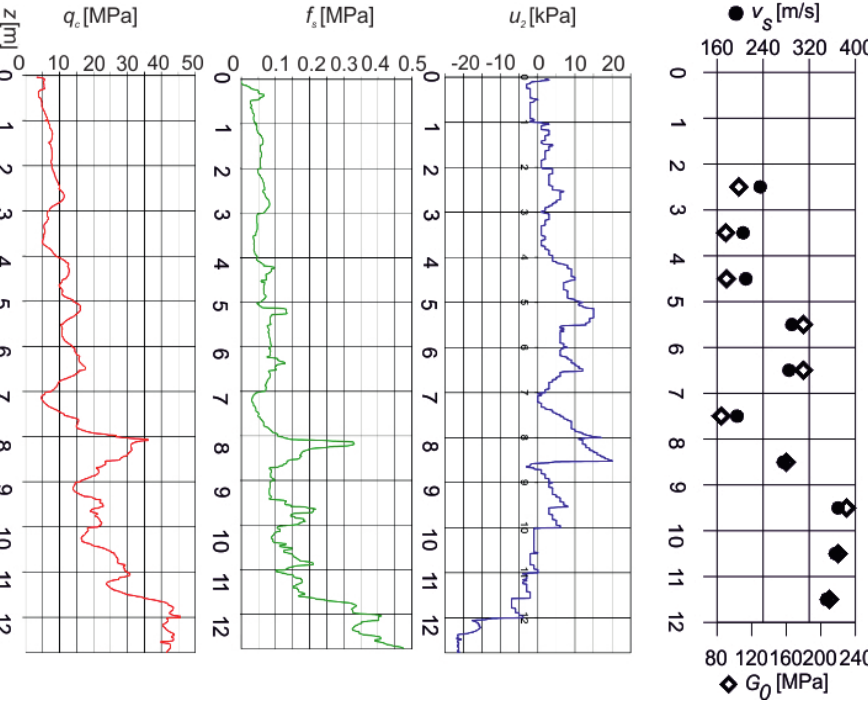
Figure 3: The example SCPTU profile at Gnojewo test site.